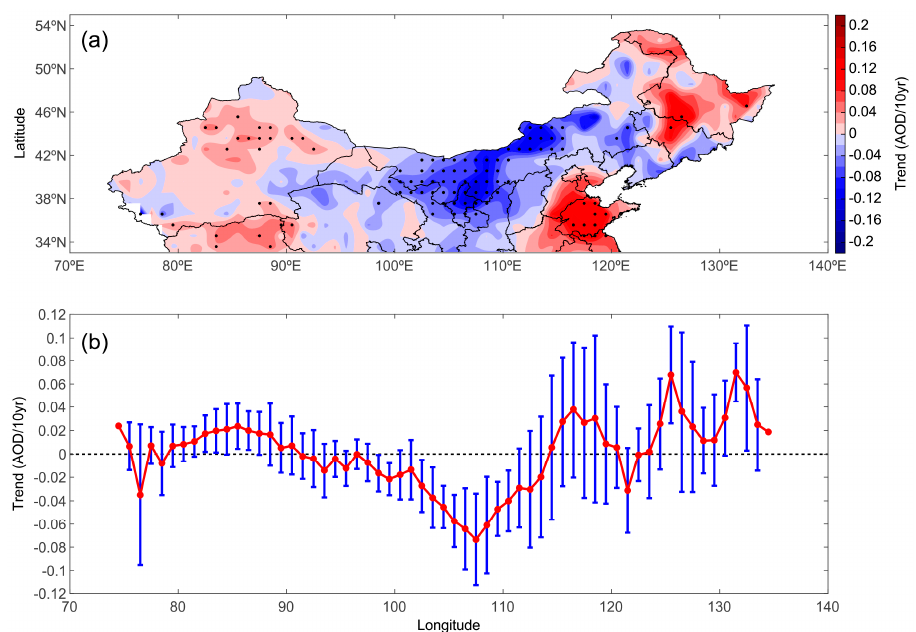
Figure 7. Annual spatial distributions of linear trends from MODIS AOD over North China from 2001 to 2016 ( a ), and the corresponding meridionally averaged trends ( b ). Dots indicate significance at 95% confidence level.